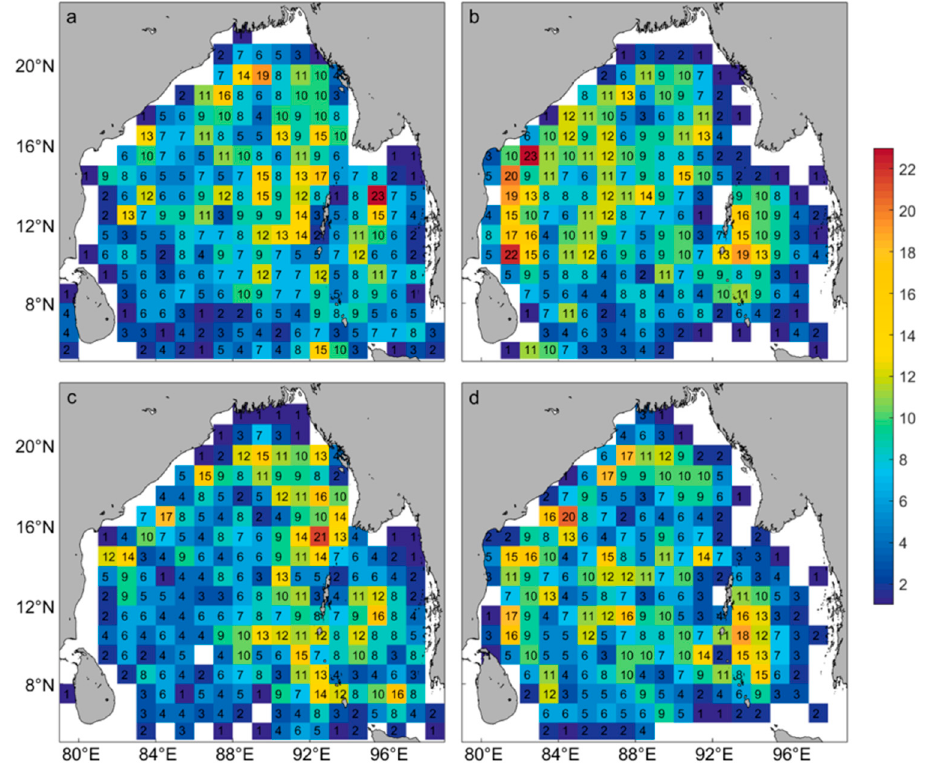
Figure 11. Spatial distributions of eddy generation number for CEs ( a ) and AEs ( c ) and dissipation number for CEs ( b ) and AEs ( d ) (lifespan ≥ four weeks) over 1° × 1° bins.